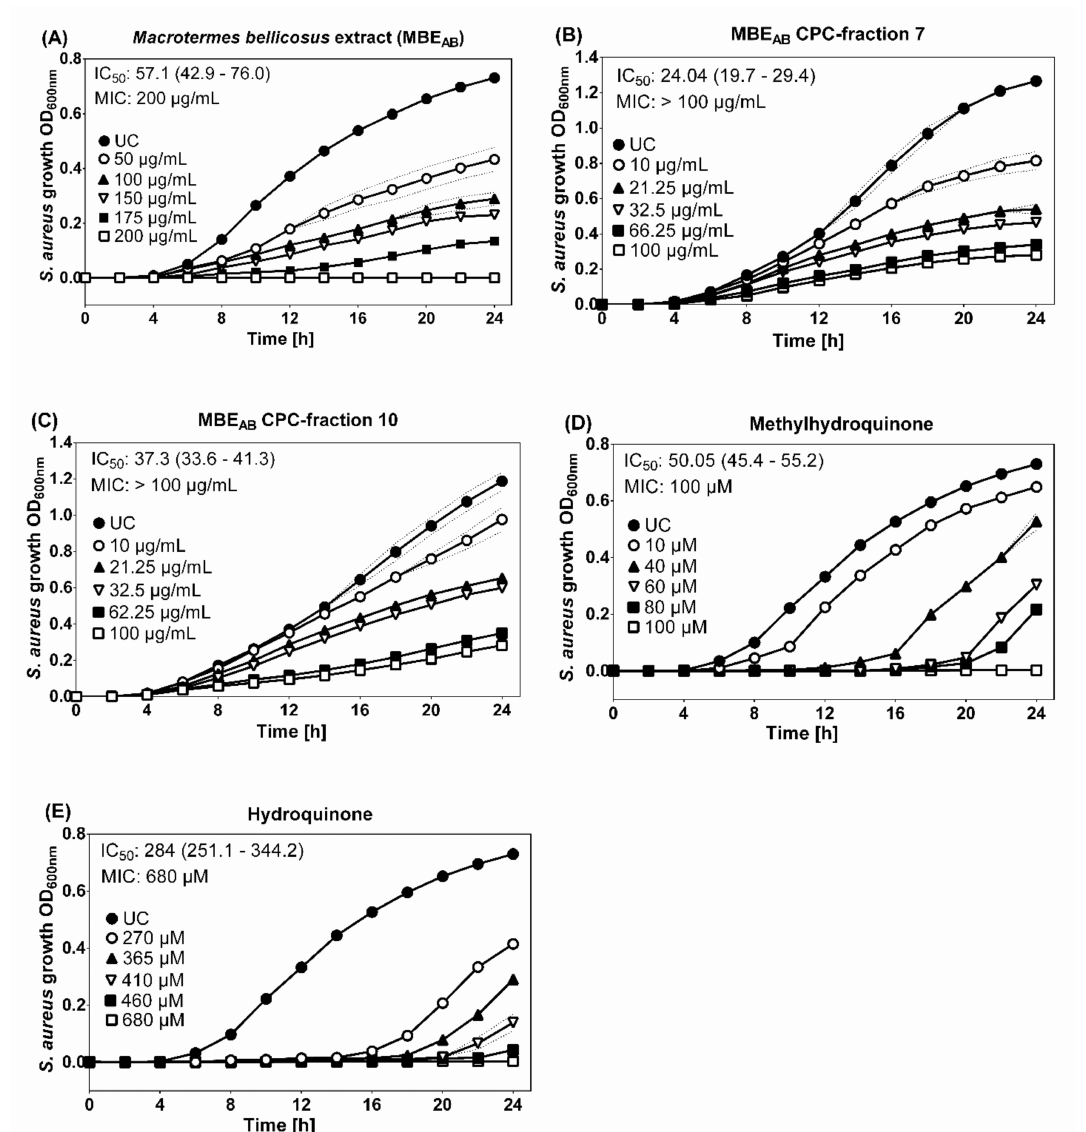
Figure 3. Growth curves of S. aureus incubated with ethanolic M. bellicosus extracts (soldier caste) collected in Abomey Calavi, MBE AB ( A ); MBE AB CPC-fraction 7 ( B ); MBE AB CPC-fraction 10 ( C ) as well as the reference substances methylhydroquinone ( D ) and hydroquinone ( E ). The data shown are a compilation of four independent experiments done in triplicate with optical density at 600 nm (OD 600nm ). Data are presented as mean ± SD (dotted line); IC 50 (95% confidence